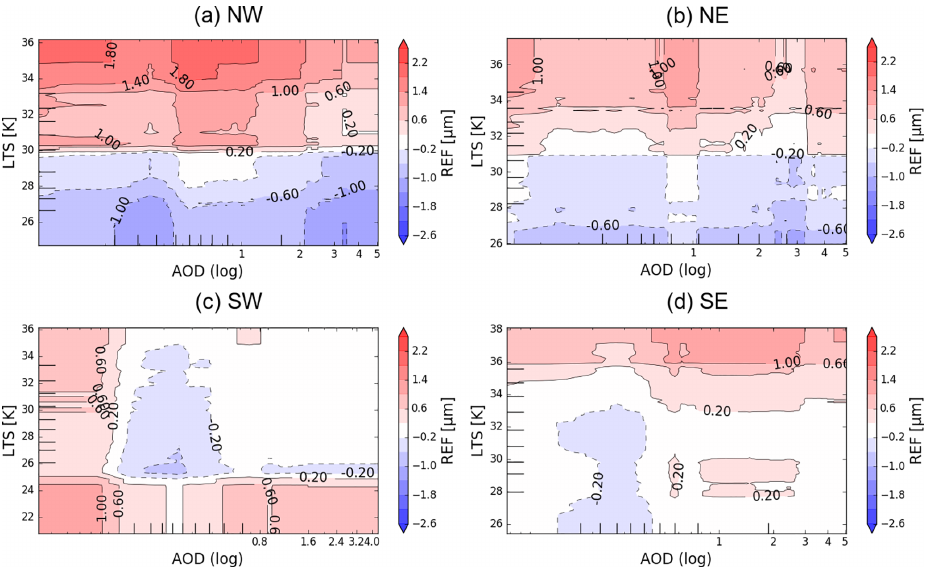
Figure 9. Two-variable partial dependence of REF on LTS and AOD in the four subregions NW (a) , NE (b) , SW (c) and SE (d) during JAS. Description as in Fig.